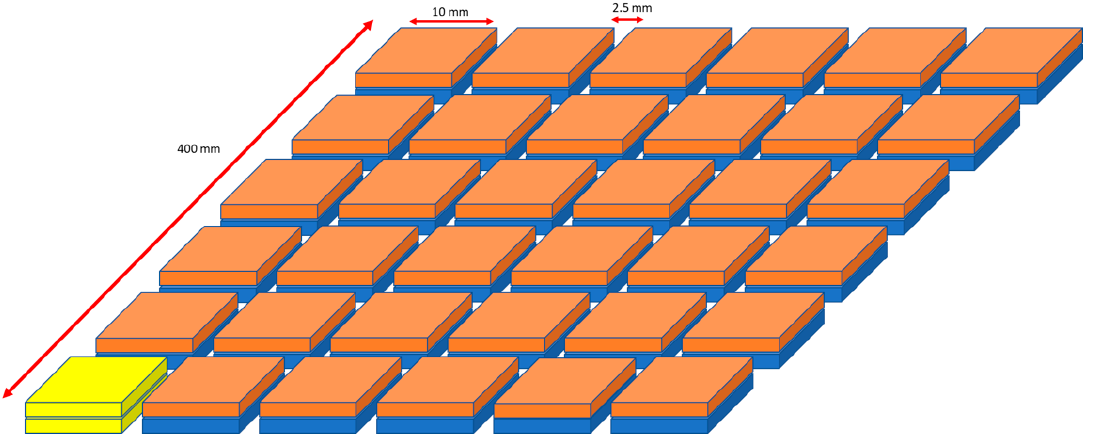
Figure 2. Sample layout in the chamber of EOS M 400 system.